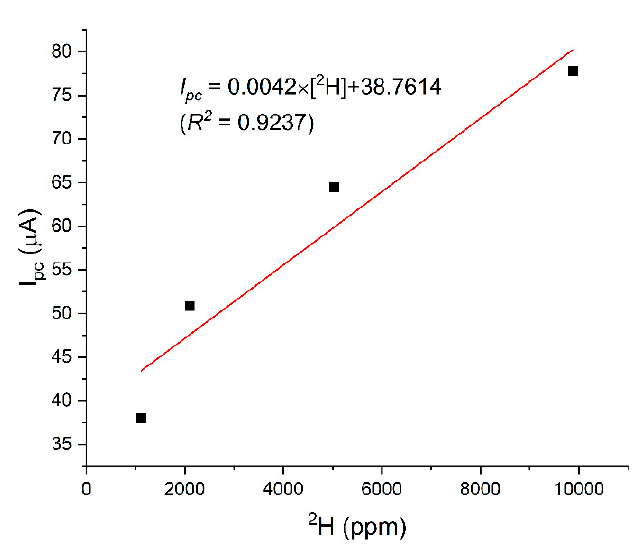
Figure 4. Concentration of 2 H water vs. current.